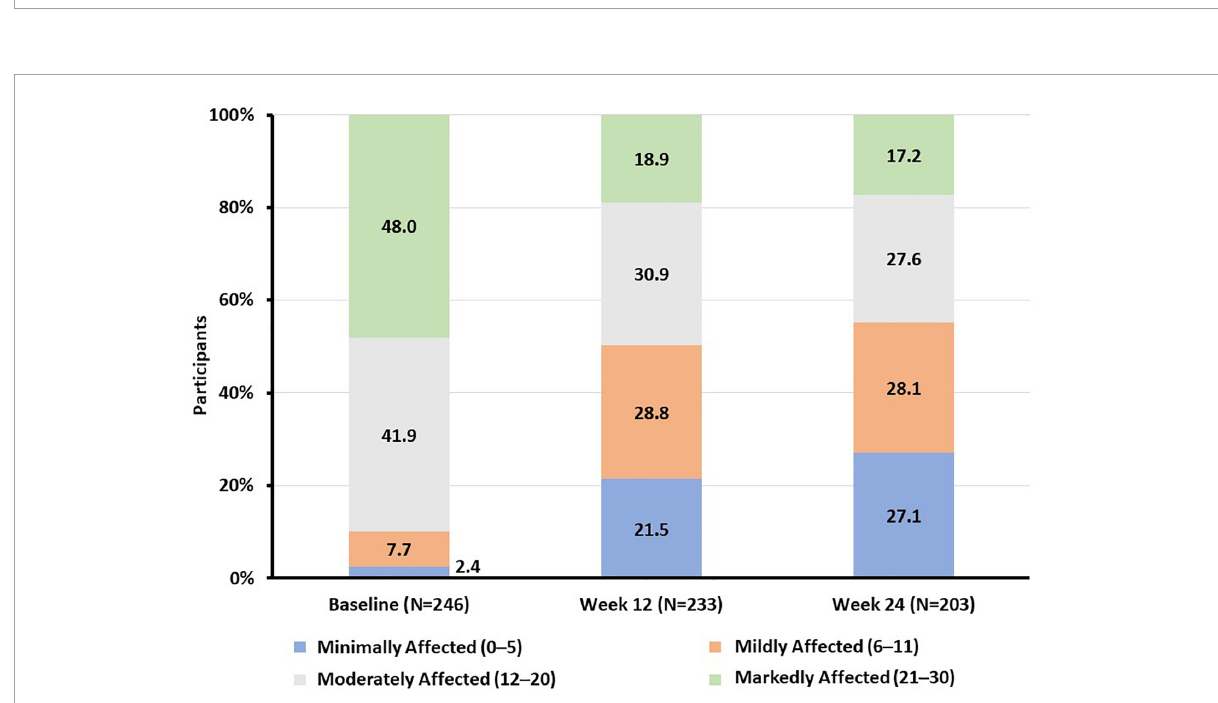
FIGURE2 Proportion of participants according to SDS total score functional impairment category at baseline and weeks 12 and 24. SDS, Sheehan Disability